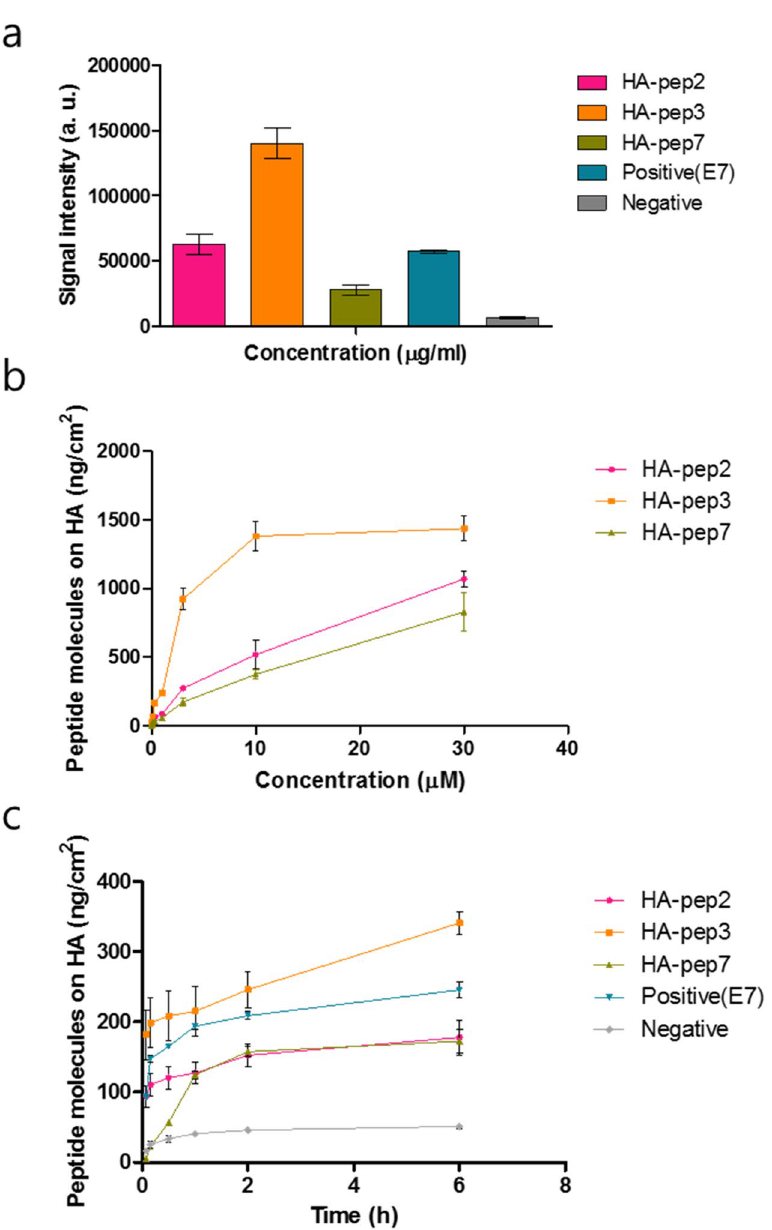
Figure 3. Binding studies of FITC-labeled HA-specific peptides. ( a ) HA-binding test of selected peptides (HA-pep2, HA-pep3, HA-pep7), positive peptide(E7) and negative peptide. ( b ) Binding assay of HA-binding peptides in different concentrations and ( c ) incubation